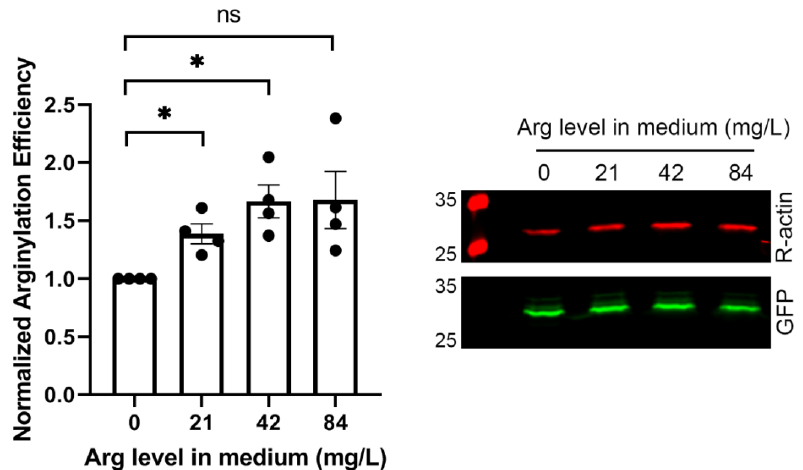
Figure 4. Addition of free Arg to the tissue culture medium increases the efficiency of arginylation. Chart ( left ) and representative Western blot image ( right ) of sensor-based quantification of arginyla- tion in cells grown in Arg-free media supplemented with different amounts of Arg, as indicated. Error bars represent SEM; n = 4 independent transfections; * p < 0.05, ns, not significant, Welch’s t -test.